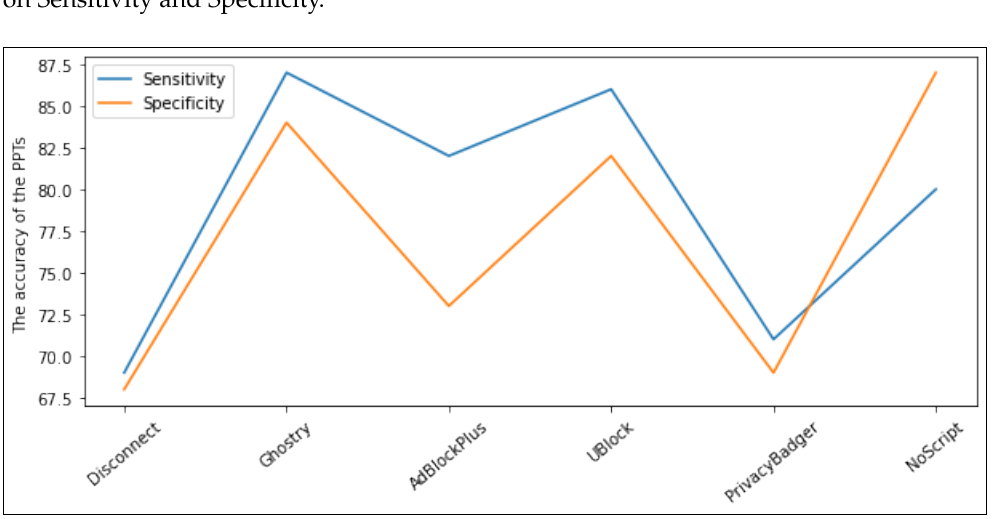
Figure 5. Shows the ratio between sensitivity and specificity of the